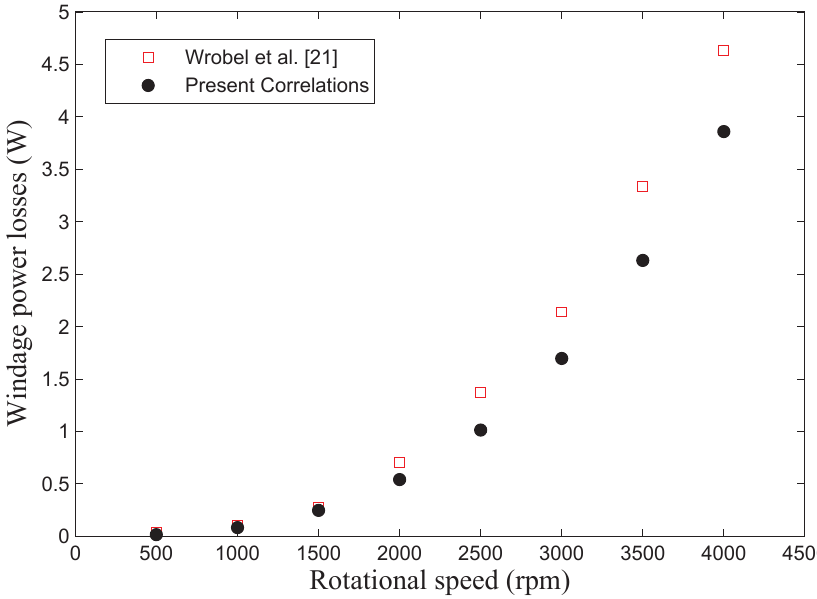
Figure 9. Comparison of the results of the windage losses due to viscous forces for surfaces in the gap region with the data reported by Wrobel et al. [21] at G = 0.0156, L = 0.0376 and α m =